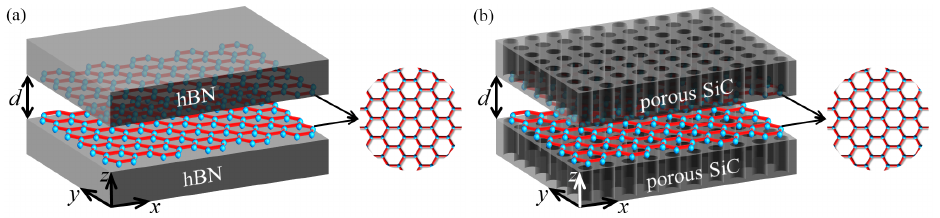
Figure 1. The Casimir force between two graphene-covered HMs separated by d is depicted schemat- ically. Two models under consideration: ( a ) graphene-covered hBN and ( b ) graphene-covered porous SiC.